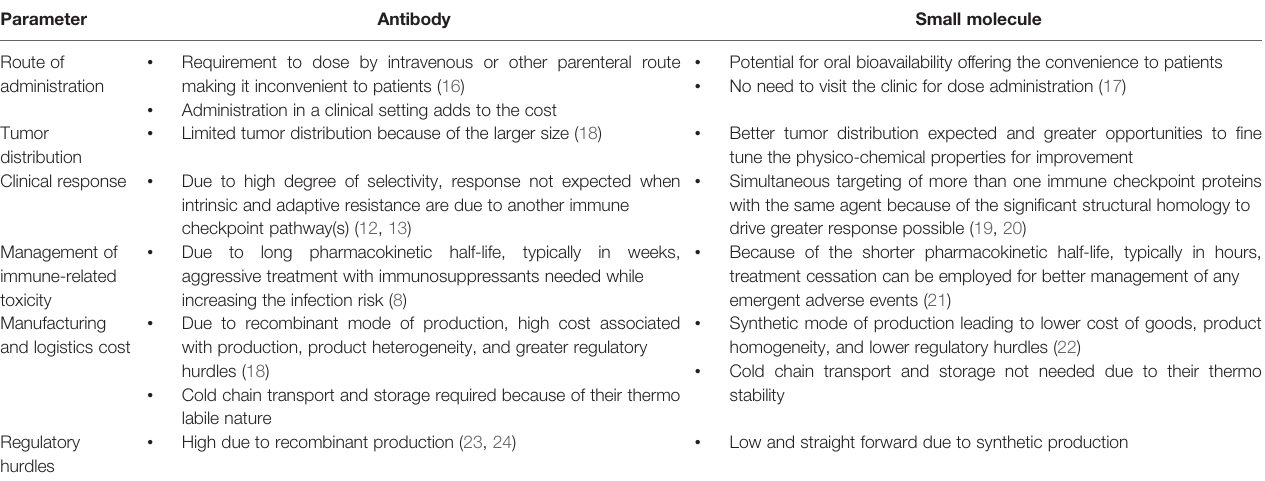
TABLE 1 | Advantages of small molecule agents over antibodies to target PD-1 and other immune checkpoint pathways. Parameter Antibody Small